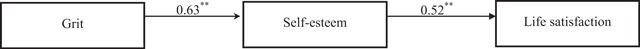
Path Coefficients of the Hypothesized Model.Notes: N = 243.* p < .05. ** p < .01.